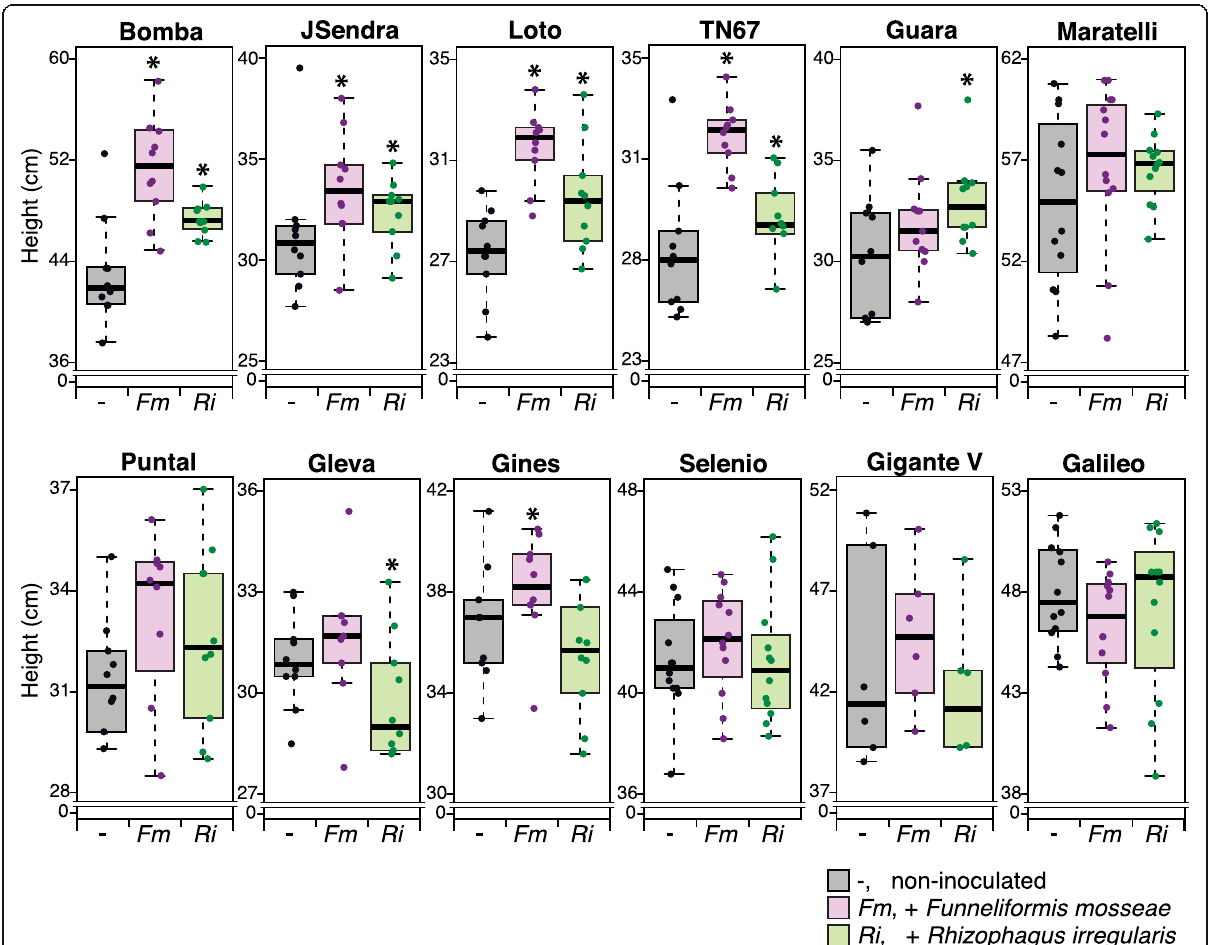
Fig. 1 Growth of AM-inoculated rice varieties. Rice cultivars (temperate japonica genotypes) were inoculated with either F. mosseae or R. irregularis . Three weeks after inoculation with the AM fungus, plant height was measured (see Additional file 1: Figure S1a for the experimental design). Values in boxplots represent biological replicates ( n =12). Error bars indicate the first and third quartiles. The horizontal line within the box represents the median value (i.e., 50th percentile). Outliers are represented. Two independent experiments were carried out with similar results. Asterisks denote statistical differences (* P <0.05, ANOVA